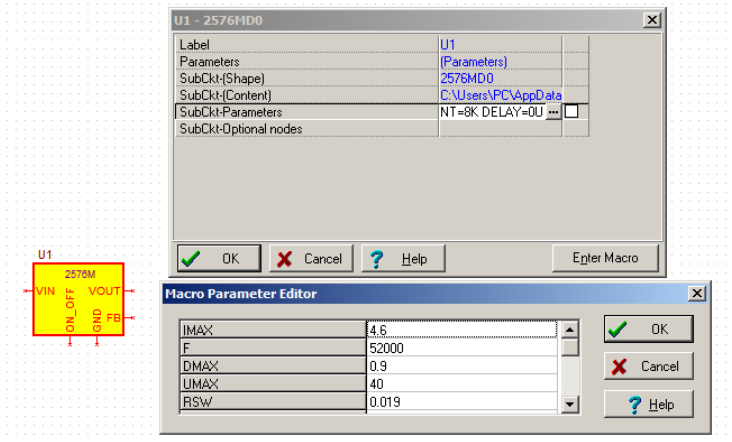
Figure 3. Graphic symbol and property windows of the LM2576 switched voltage regulator model in the TINA program.